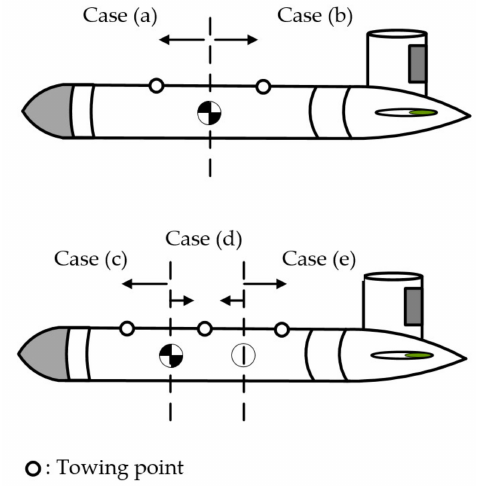
Figure 6. Five cases ((a)–(e)) used to discuss effect of towing point and center of